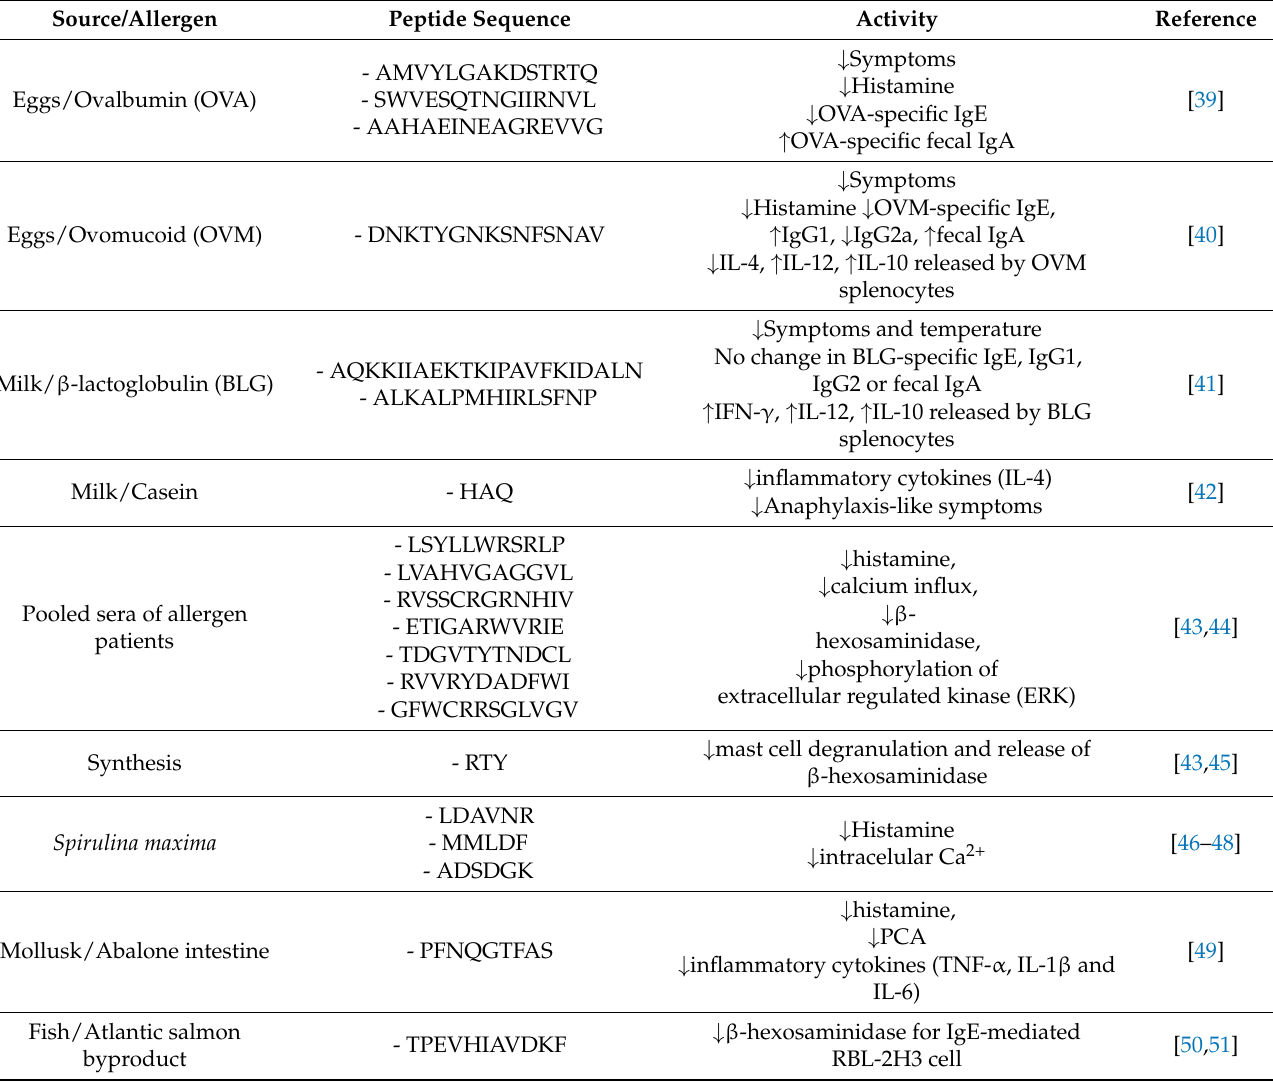
Table 2. Previously described bioactive peptides with anti-allergic effects. ↑ Increase; ↓